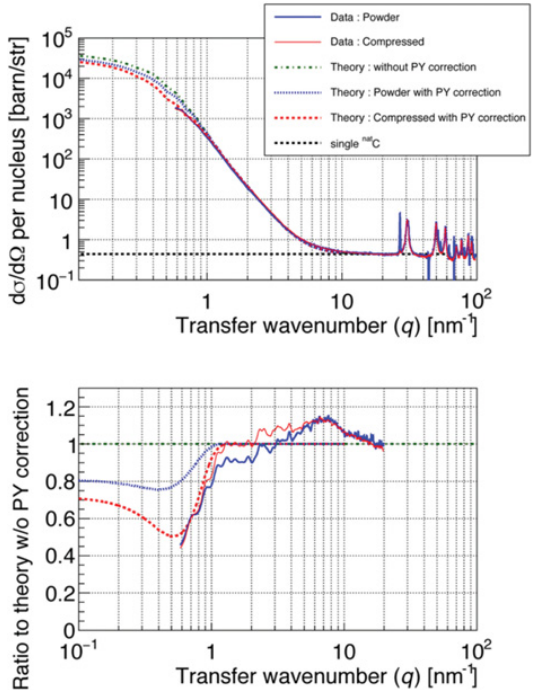
Figure 10. Top: Smoothed differential scattering cross sections for the compressed (solid red) and powder (solid blue) samples. The three theoretical curves display the cross sections with PY hard-sphere correction for the compressed (dot-blue) and the powder (dash-red) sample, and without correction (dot-dash green). The black dashed line shows the cross section of a single carbon nucleus. Bottom: Ratios of theoretical cross sections with and without PY correction, together with the smoothed experimental data (line styles corresponding to the top